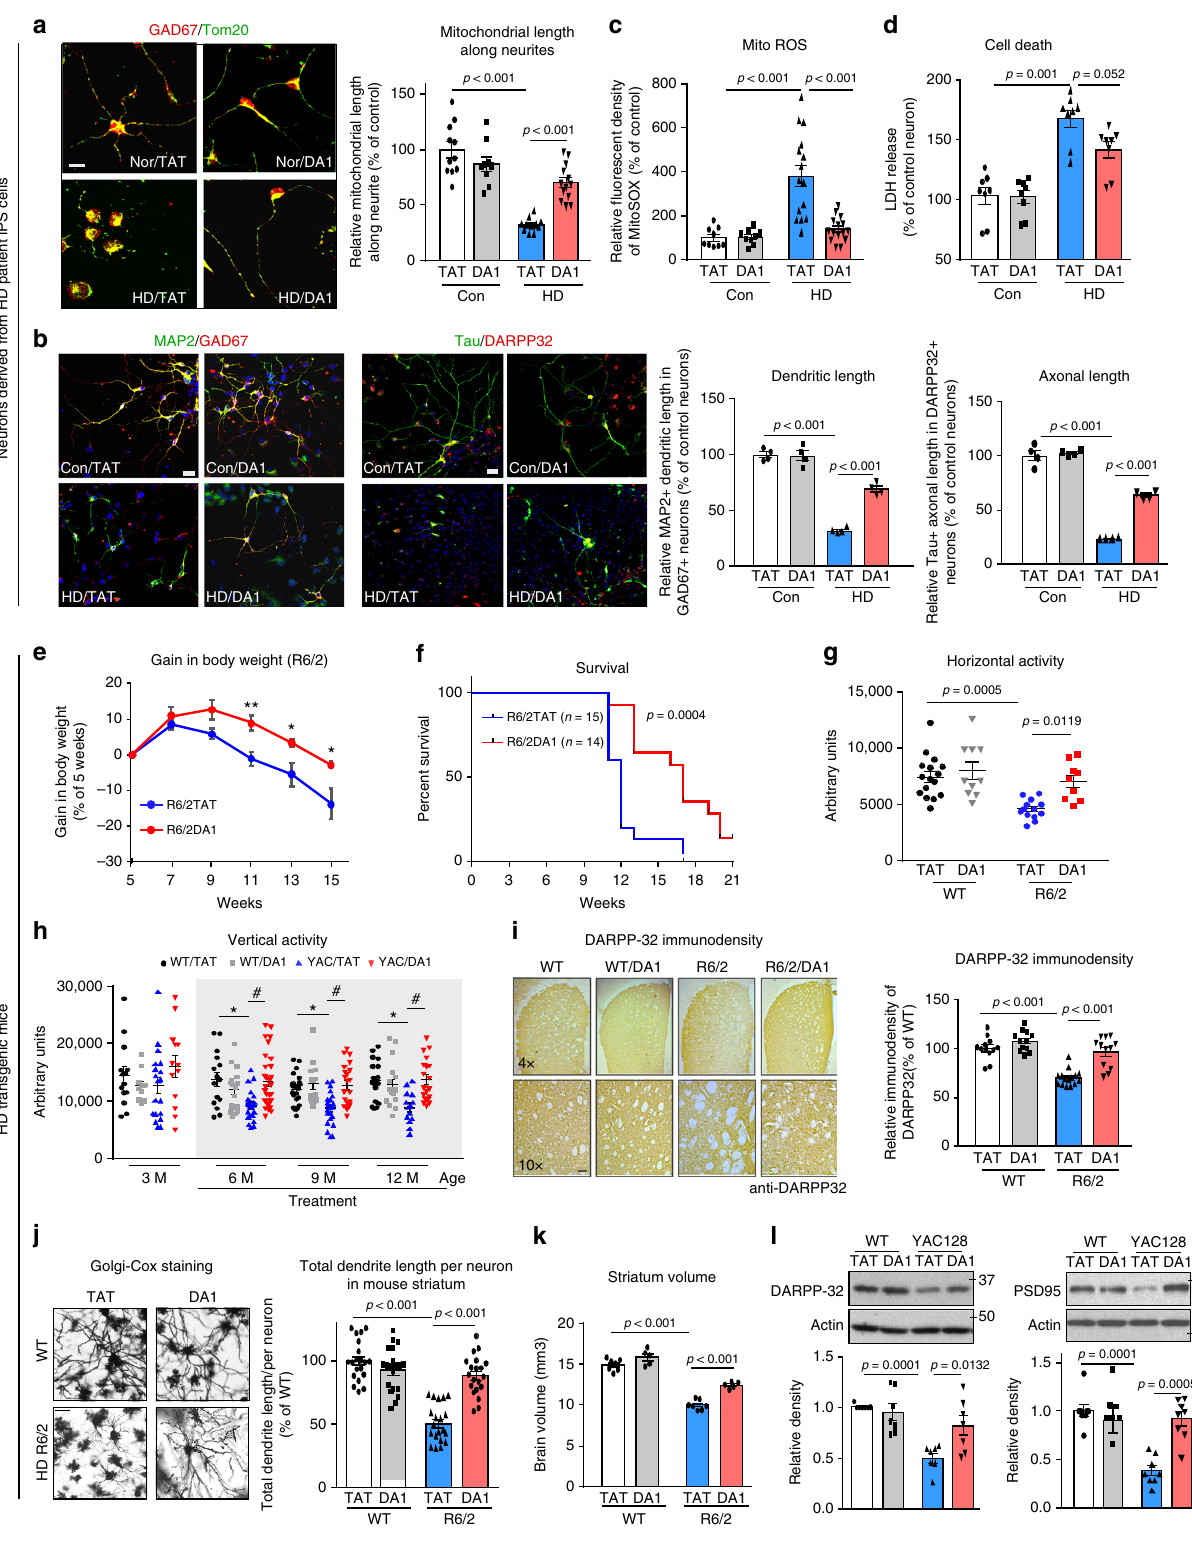
distance at the age of 12 weeks (Fig. 7g and Supplementary Fig. 8E), and reduced the severity of clasping behavior over a four-week observation period (Supplementary Fig. 8F). In YAC128 mice that exhibit progressive de fi cits in movement activity, sustained treatment with DA1 improved general